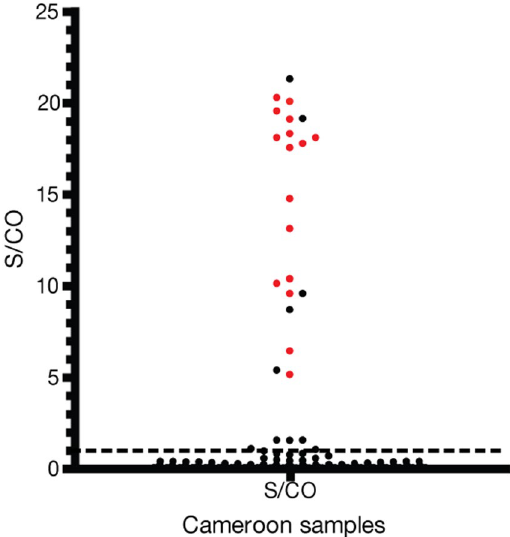
Figure 4. Scatterplot of anti-HDV IgG S/CO values for samples from Cameroon. S/CO values of Cameroon HBsAg (n = 145) samples tested with the prototype anti-HDV IgG assay. The cut-off (S/CO = 1.0) is indicated by the dotted line. Red circles indicated HDV RNA positive samples.